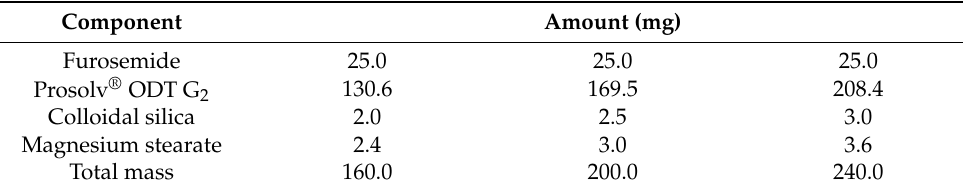
Table 1. Composition of ODTs of different